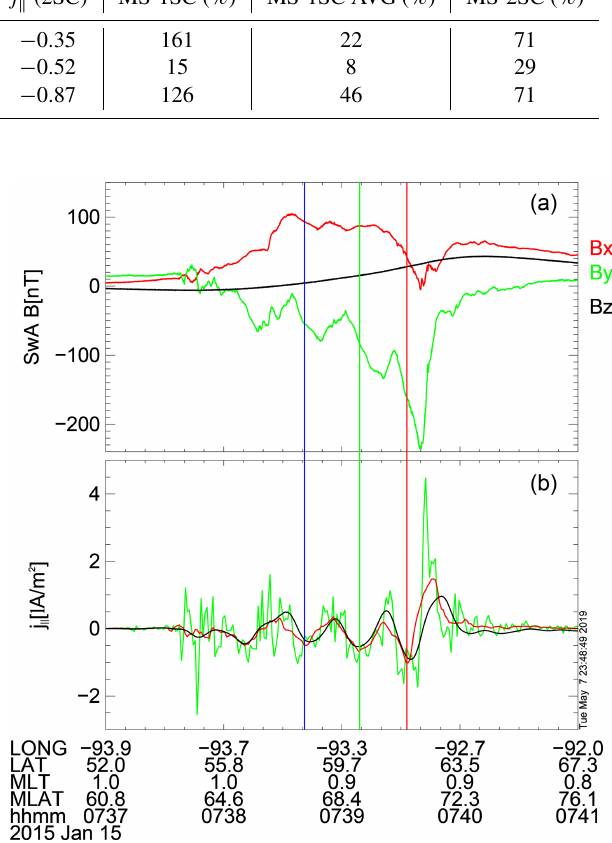
Figure 11. (a) (cid:49) B from SwA; (b) FAC density estimates, L2 single-spacecraft (green), L2 dual-spacecraft (black), average L2 single-spacecraft